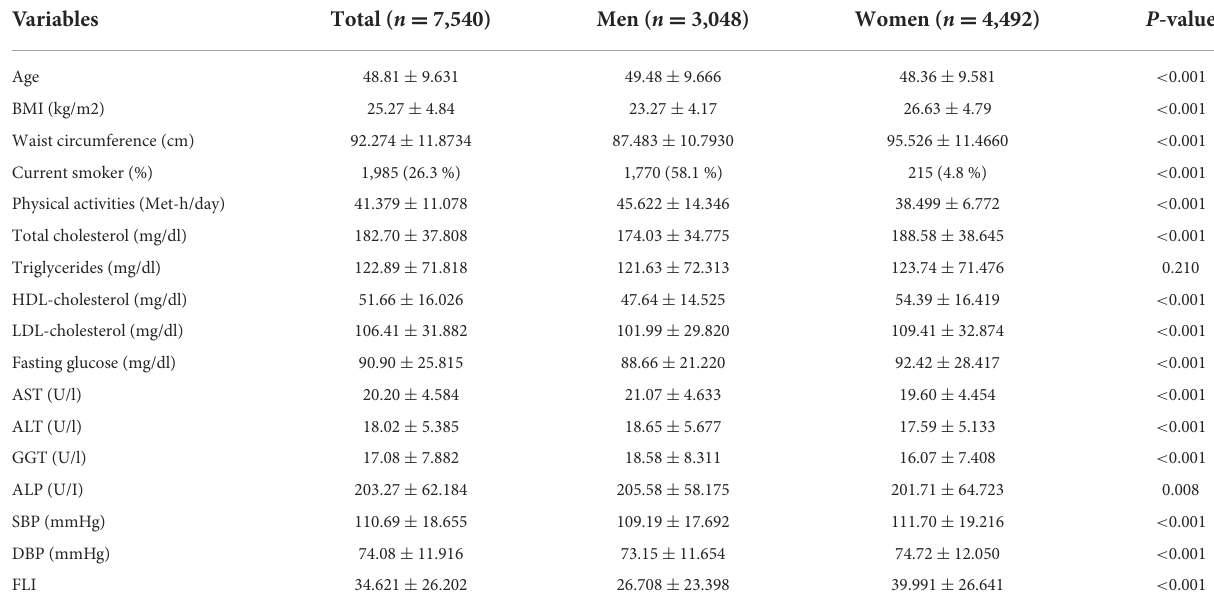
TABLE 1 Baseline characteristics of study